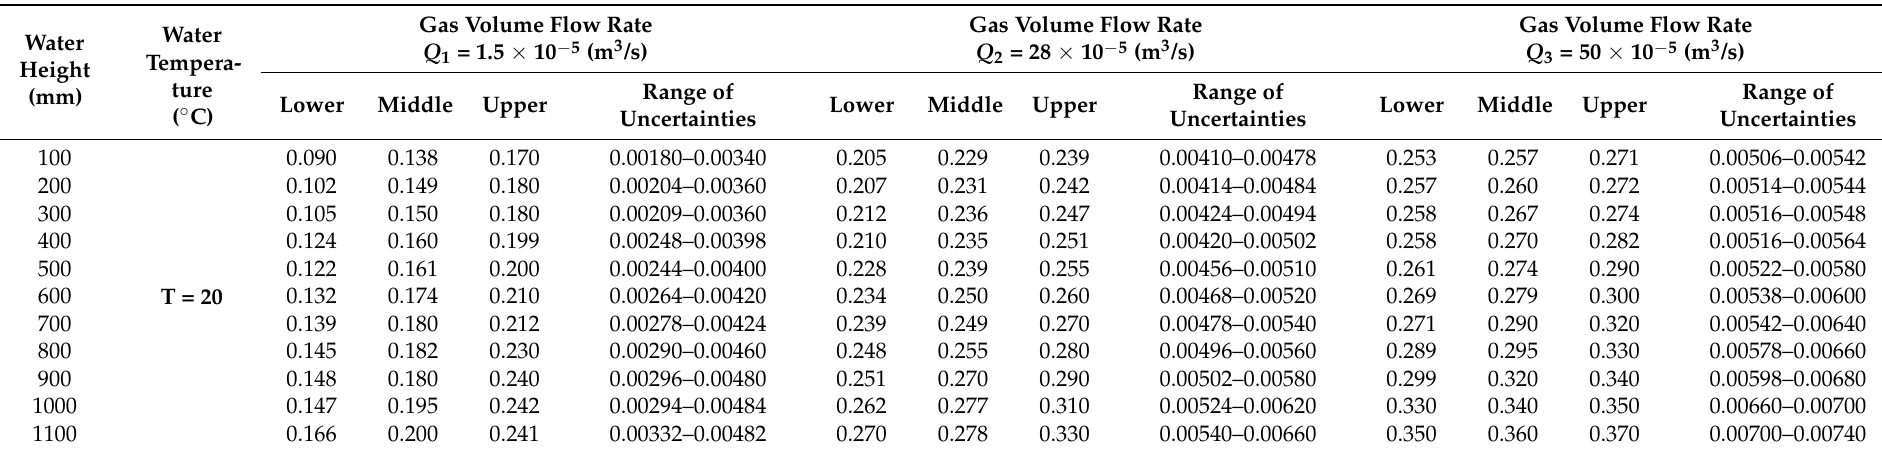
Table 6. Bubble speed (m/s) as a function of water height for T = 20 ◦ C and for gas volume flow rates Q 1 –Q 3 .